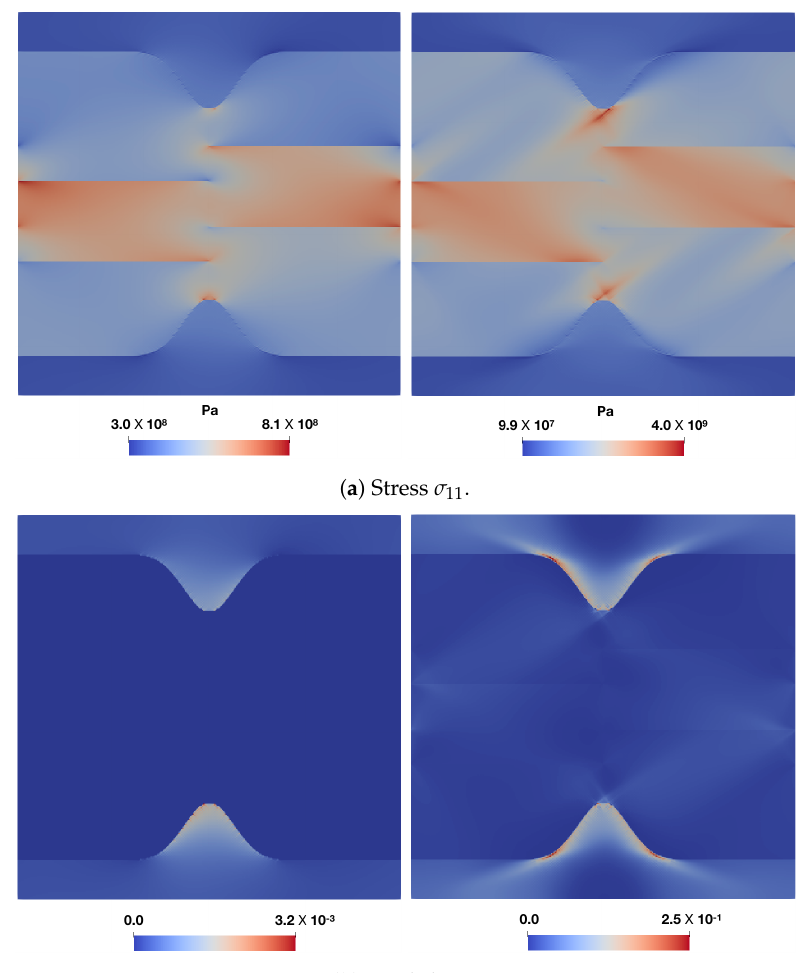
Figure 10. Stress component σ 11 and total accumulated shear (constituting martensite region from prior austenites levels, ¯ F 11 = 1.00125 ( left column) and ¯ F 11 = 1.00875 ( right